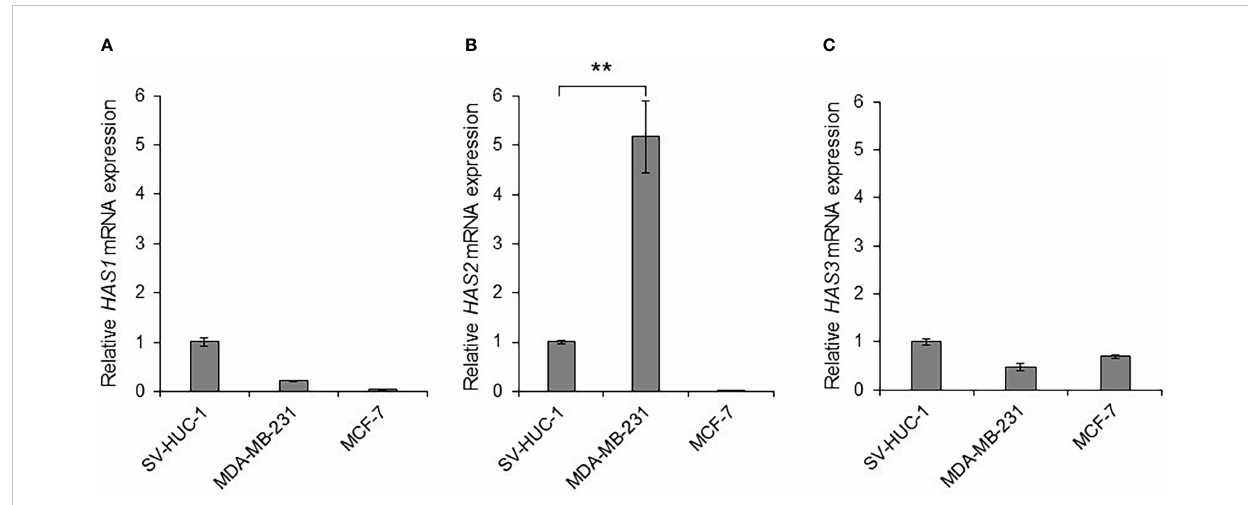
FIGURE 3 Detection of hyaluronan synthases (HAS1, HAS2, and HAS3) mRNA in MDA-MB-231 and MCF-7 cells (A) The mRNA expressions of HAS1 , HAS2 and HAS3 in MDA-MB-231 and MCF-7 cells were measured by real-time RT-PCR and compared to those in non-malignant SV-HUC-1 cells. The mRNA expressions of HAS1 in MDA-MB-231 and MCF-7 cells was not increased compared to those of SV-HUC-1 cells. (B) The mRNA expression of HAS2 in MDA-MB-231 cells was signi fi cantly increased compared to that in SV-HUC-1 cells, but not in MCF-7 cells. (C) The mRNA expressions of HAS3 in MDA-MB-231 and MCF-7 cells was not increased compared to that in SV-HUC-1 cells. mRNA levels were standardized by the expression levels of control gene TATA-binding protein ( TBP ). (n=3, average ± SE bars, **p<